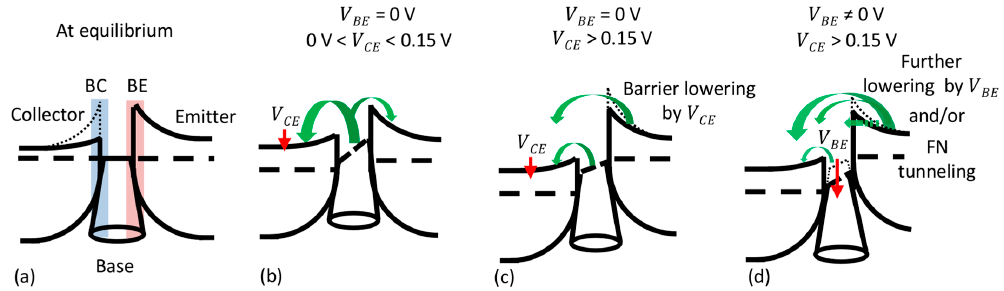
Figure 5. Simplified band diagrams of the graphene-base heterojunction transistor during ( a ) equilibrium (BC ideal barrier shown as a dashed line). Band diagram at V BE = 0 V for ( b ) 0 V < V CE < 0.15 V and ( c ) V CE > 0.15 V, and at V BE (cid:54) = 0 V for ( d ) V CE > 0.15 V. The green arrows indicate the flow of electrons.